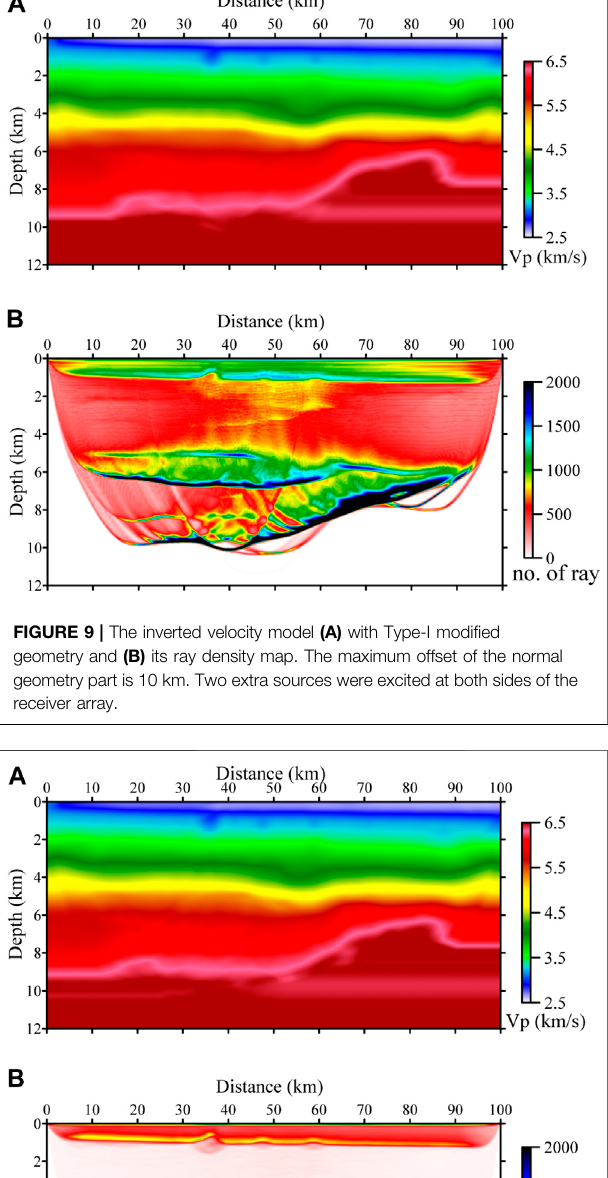
Frontiers in Earth Science |